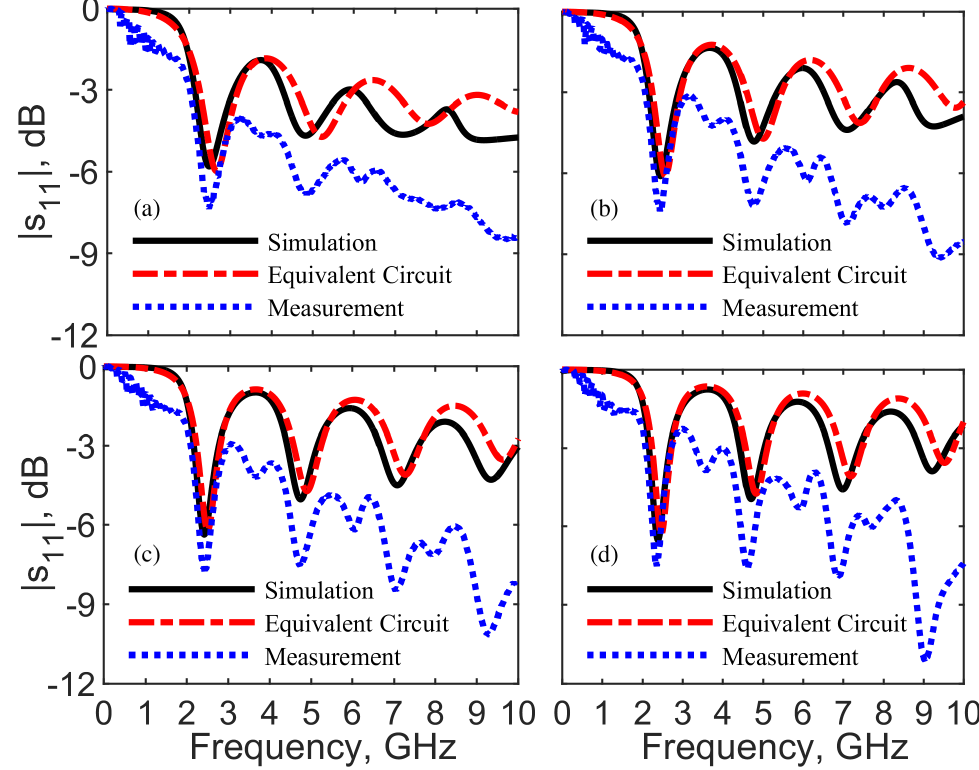
Figure 5. Comparison of simulations, equivalent circuit results and measurements for loops with U = ( a ) 8, ( b ) 9, ( c ) 10, and ( d )